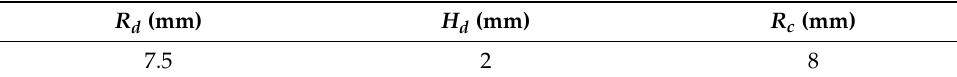
Figure 1. Schematic diagram of the gemetry in the r - z plane. Table 1. Model parameters.